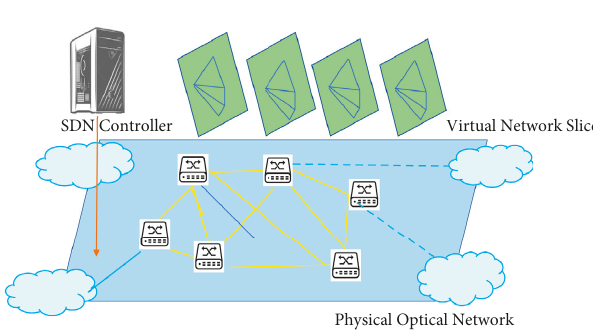
Figure 13: VON-SDN provisioning